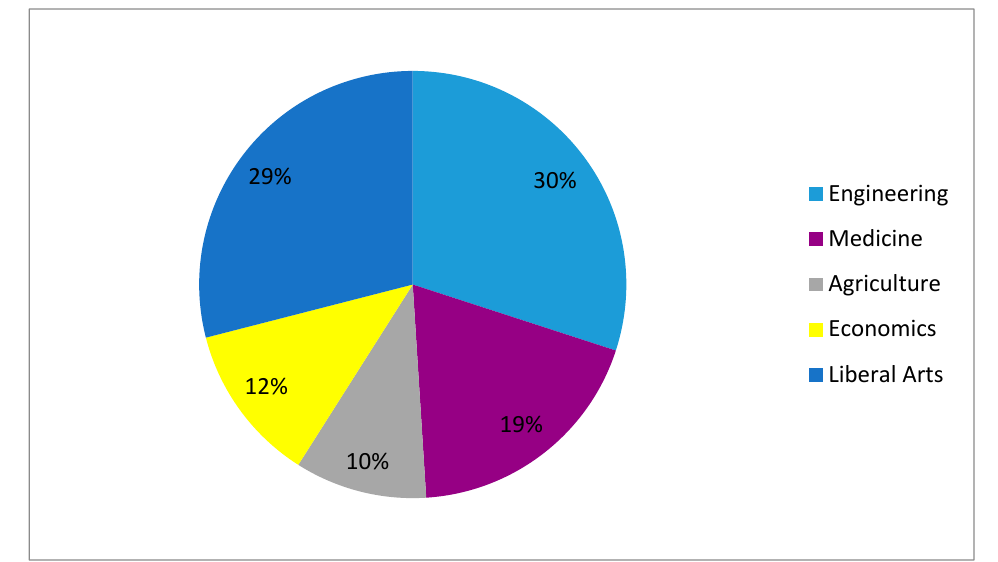
Figure 1. Percentage of participants by major.